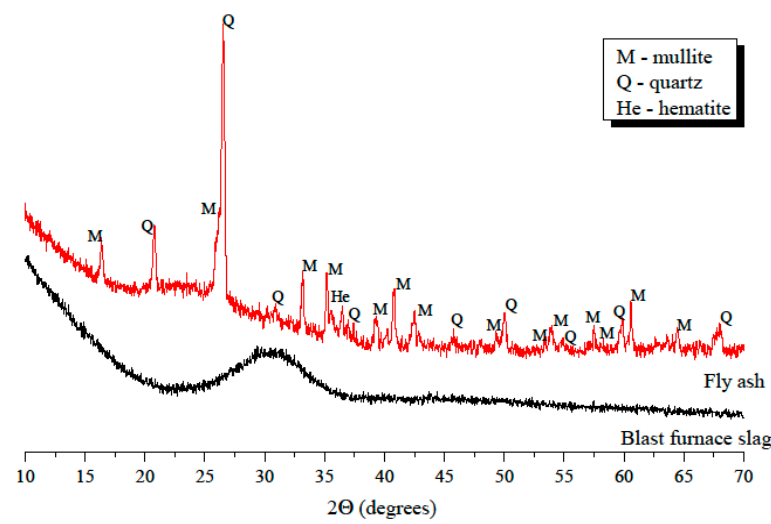
Figure 3. XRD diffractograms for GBFS and FA.